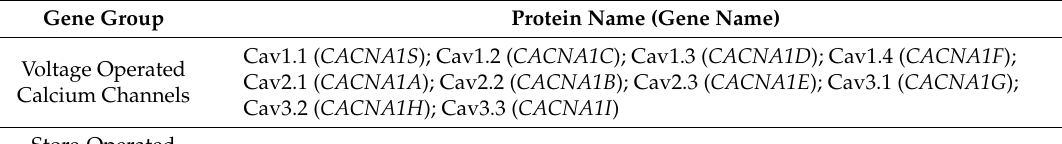
Table 1. Genes involved in calcium transport analyzed in this study pooled by gene